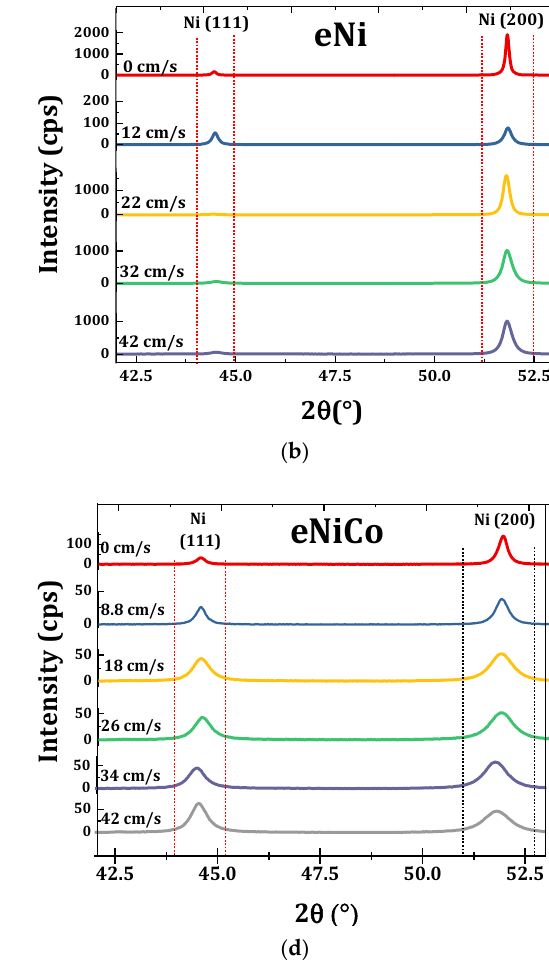
Figure 9. XRD diffractograms showing textured growth with predominant (200) and (111) Ni peaks as function of BHD; ( a ) eNi coating samples (scanning range 10–90°); ( b ) Magnified view (42–53°) of the predominant peaks of eNi coating samples; ( c ) eNiCo alloy coating samples (scanning range 10–90°); and ( d ) Magnified view (42–53°) of the predominant peaks of eNiCo alloy coating samples.